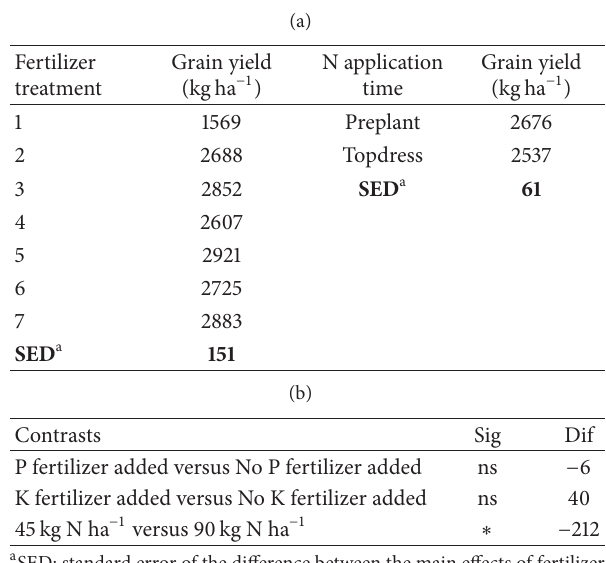
Table 7: Grain yield means and selected contrasts for the significant maineffectsoffertilizertreatmentandNapplicationtimingfor2004 growing